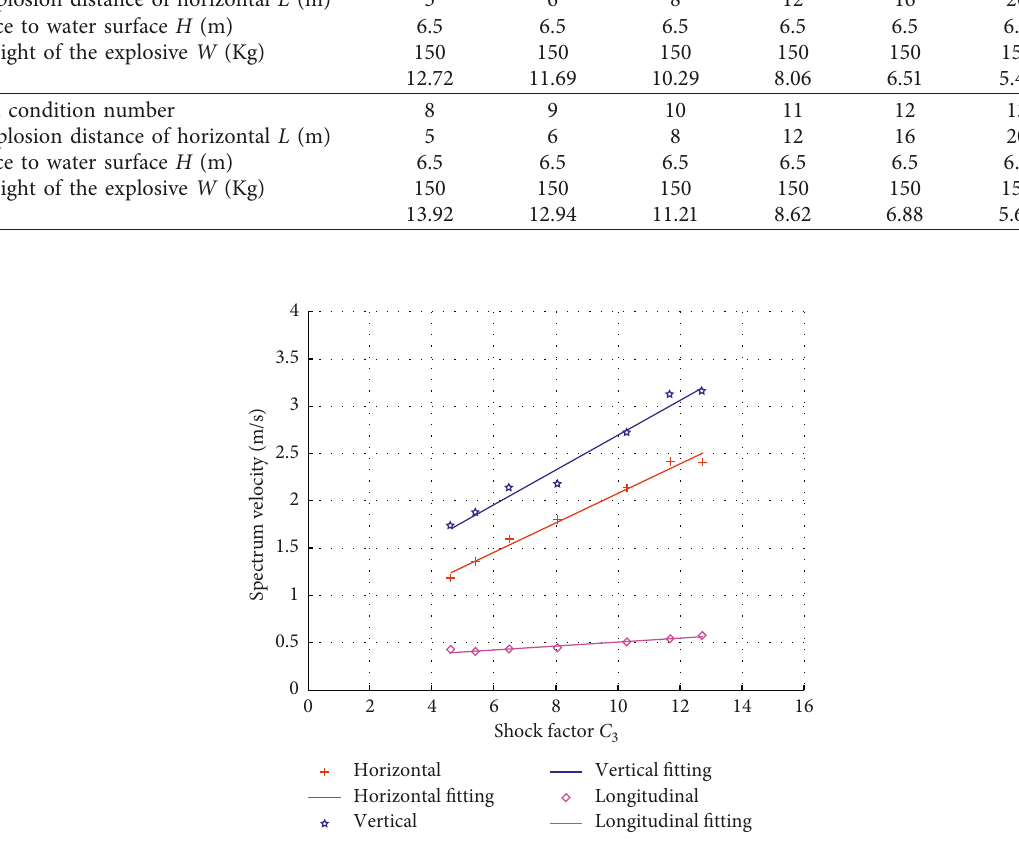
Figure 19: Linear fitting of the impact environment on the starboard